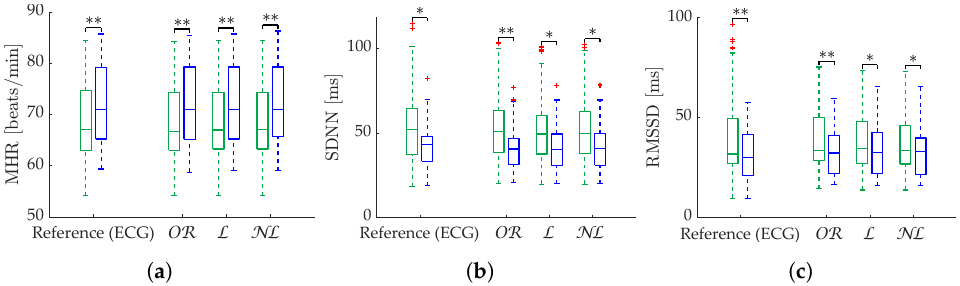
Figure 5. Relax (green)/stress (blue) discrimination of time-domain metrics from Apple Watch dataset. ( a ) MHR. ( b ) SDNN. ( c ) RMSSD. *: Significant differences ( p < 0.05) between relax and stress groups. **: Significant differences ( p < 0.001) between relax and stress